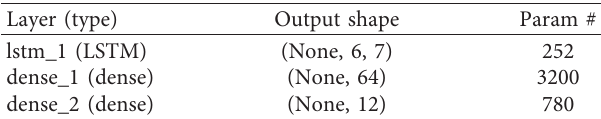
Table 7: Each LSTM network